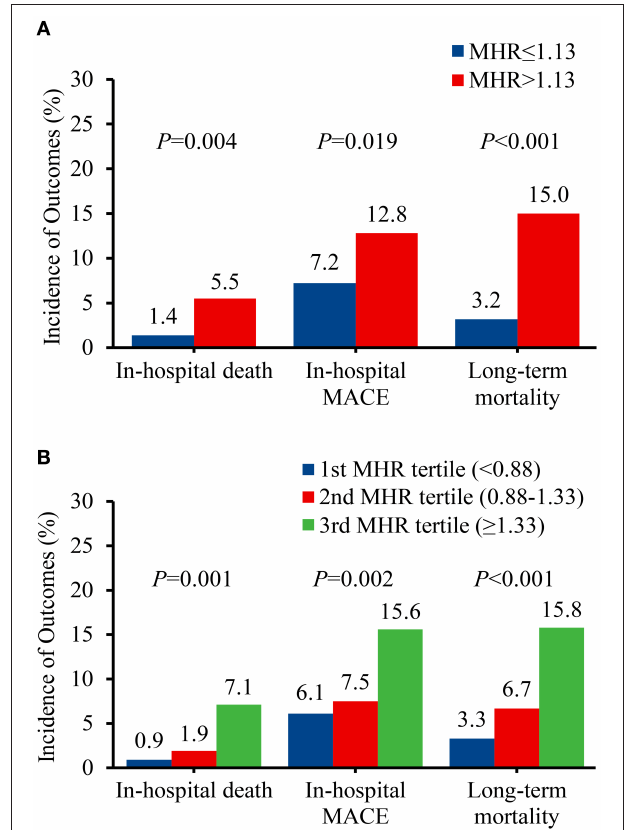
FIGURE 2 | Prevalence of adverse events before propensity score matching. (A) Classified by the receiver operating characteristic curve selected cut-off of MHR. (B) Classified by the tertiles of MHR. MACE, major adverse clinical events; MHR, monocyte to high-density lipoprotein